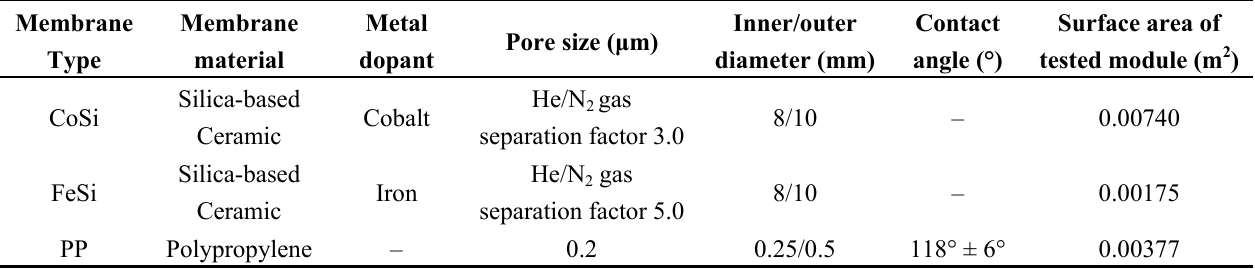
Table 1. Characterization data for various membranes. PP = polymer membrane.